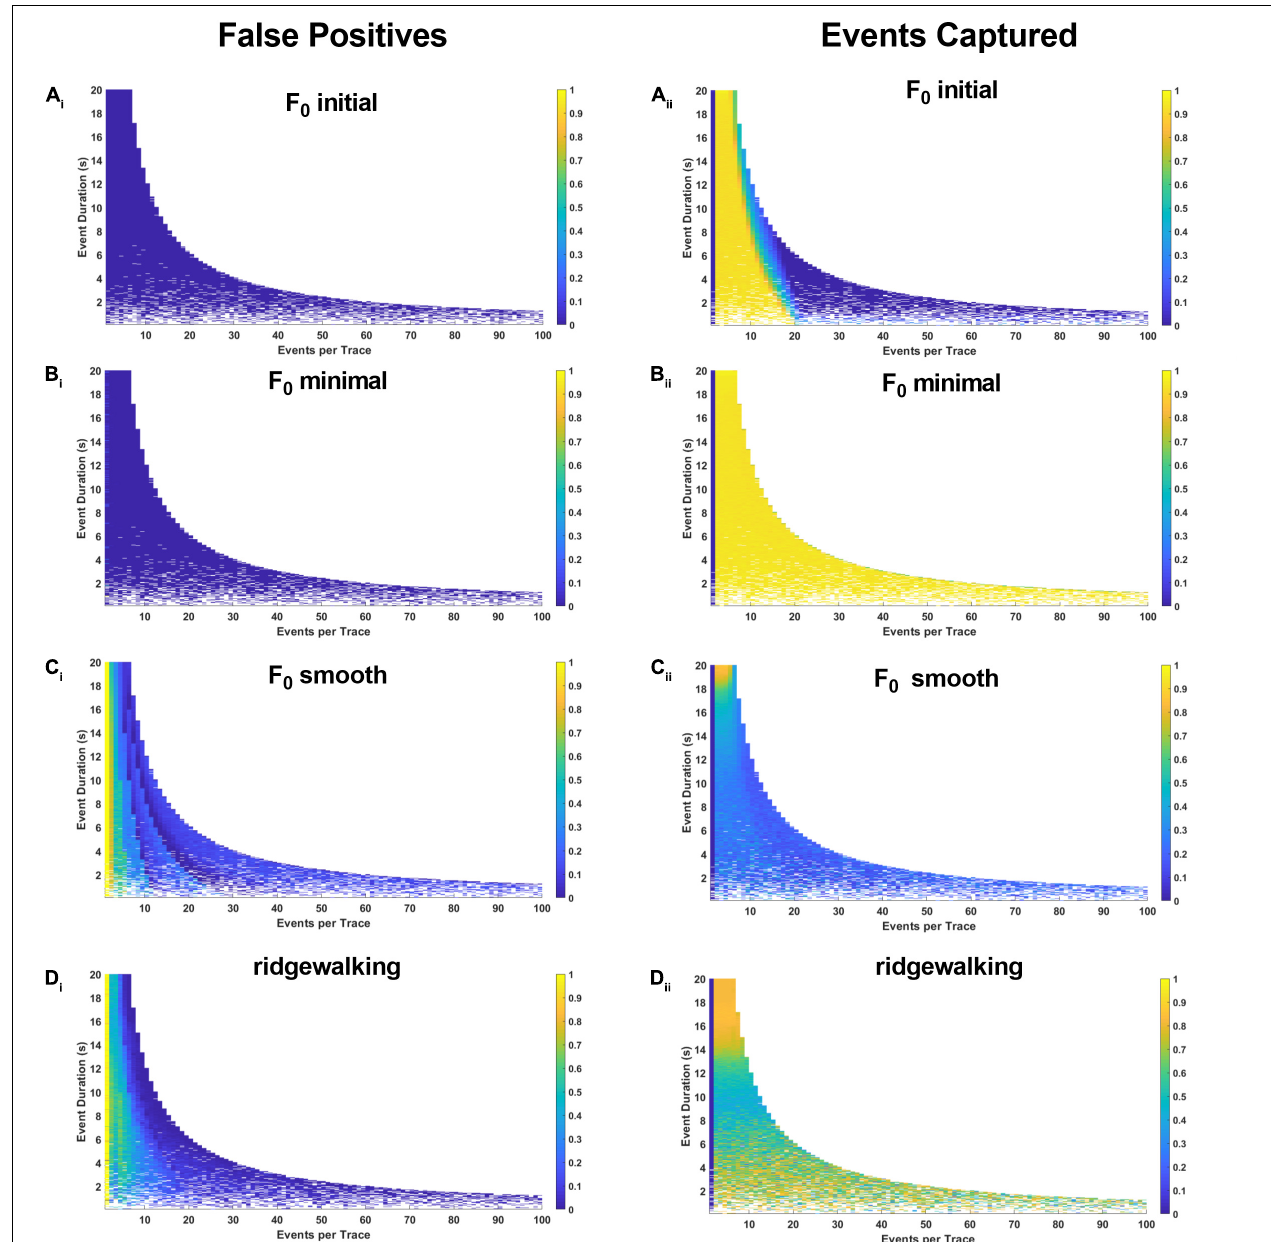
FIGURE 6 | Synthetic data for pseudoastrocytic events. The left-hand plots represent “false positives” or the fraction of rasters existing outside of known event bounds, and the right-hand plots represent the “events captured” or the fraction of total event bounds that are covered by the rasters. (A i , ii ) Results for F 0 initial thresholded at 2.5 baseline standard deviations. (B i , ii ) Results for F 0 minimal thresholded at 2.5 baseline standard deviations. (C i , ii ) Results for F 0 smooth thresholded at 2.5 baseline standard deviations. (D i , ii ) Results for wavelet ridgewalking algorithm.